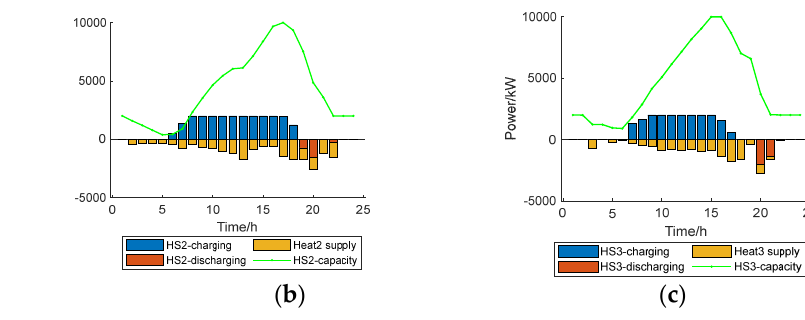
Figure 10. CSP − HS scheduling results of IES1 ( a ), IES1 ( b ), and IES1 ( c ).